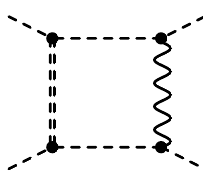
Figure 5 . Example of a heavy-light gauge-boson contribution to the one-loop matching correc- tion C (1) . Graphs with loops of only H and B (cid:22) , or H and W a H (cid:3) such diagrams do not contribute if IR divergences are regulated dimensionally. The line styles and their meanings mirror those in (cid:12)gure 3.